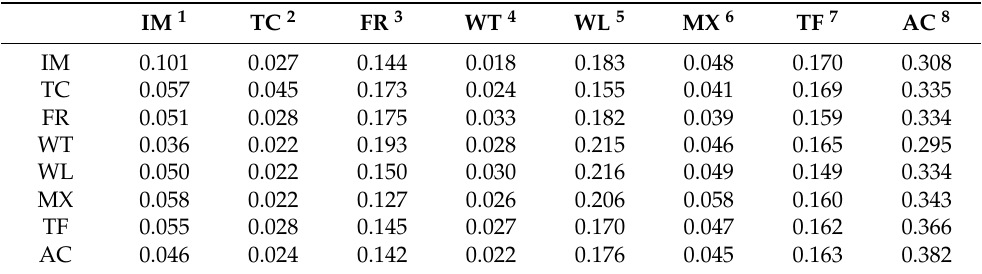
Figure 12. Visualized graph for the pre-trained spatial relationship of Kent County. From the graph, the statistics of each node’s degree with different labels according to Equation (1) were calculated. The calculation of the probability of land cover types being adjacent to each other in Kent County were the same as the Mun River Basin. Table 2 shows the probability of land cover types being adjacent to other types. Using this probability, we can aggregate the fuzzy classification result with the adjacent probabilities. Table 2. Probability of land cover types being adjacent to each other in Kent